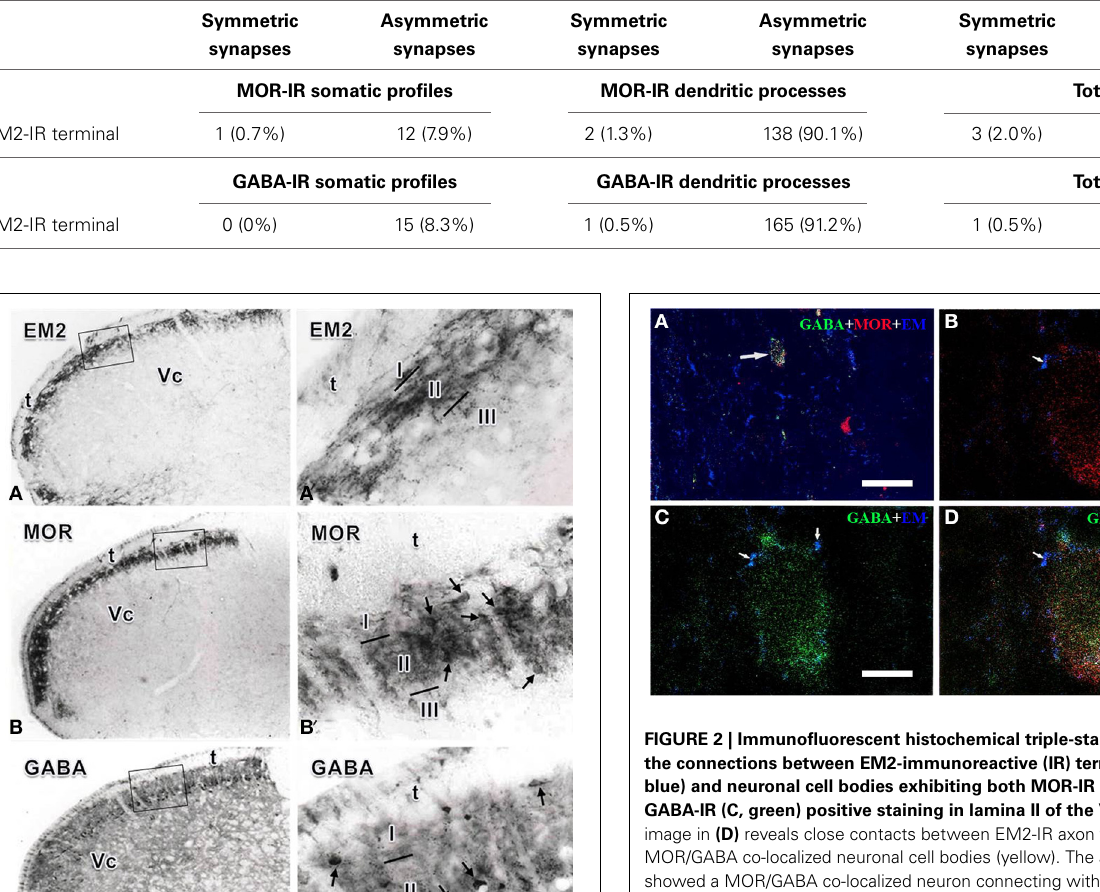
Table 4 | Synaptic types between EM2-IR terminals and MOR-IR or GABA-IR sotamic profiles and dendritic processes.